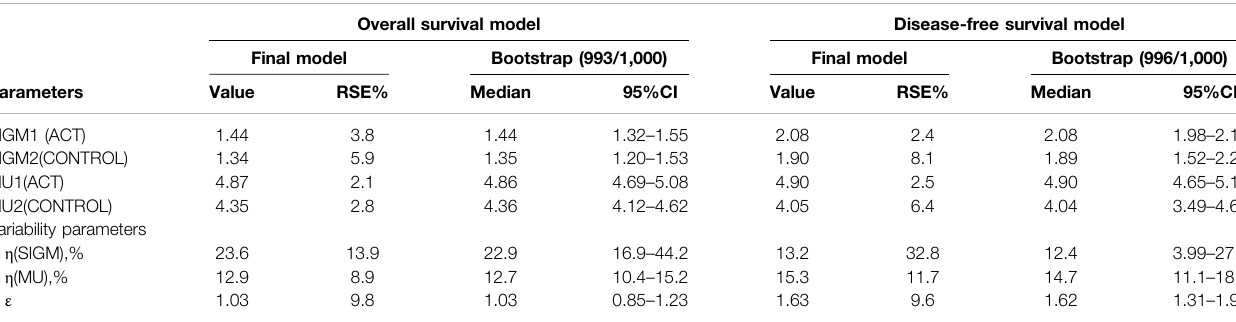
TABLE 2 | Parameter estimations of